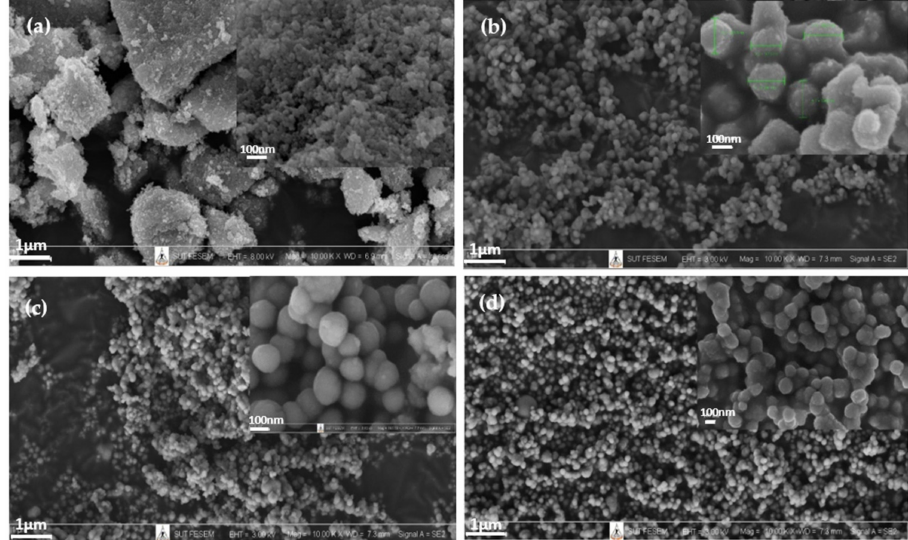
Figure 15. Low ( × 10k WD = 7.3 mm EHT = 3.00 kV) and high ( × 100k WD = 6.9–7.3 mm EHT = 3.00 kV) magnification SEM images of TiO 2 and Ti x Si y oxide synthesized at pH 9.0 with different Ti/Si ratios: ( a ) TiO 2 , ( b ) Ti 70 Si 30 , ( c ) Ti 50 Si 50 , ( d ) Ti 40 Si 60 . From the XRD patterns, only broad-range signals due to the uniform dispersion of titanium atoms onto the SiO 2 network can be seen in the XRD patterns of Ti 70 Si 30 , Ti 50 Si 50 , and Ti 40 Si 60 oxides (Figure 16). As a result, the absence of XRD diffraction signals suggests that anatase crystallization is still hindered by the titania aggregate’s segregation from the silica network